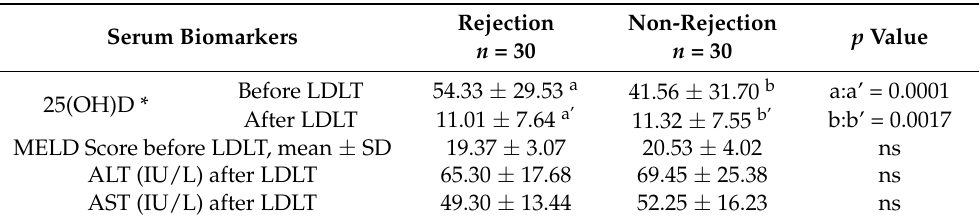
Table 4. Serum 25(OH)D concentrations in recipients before and after LDLT with rejection ( n = 30) and non-rejection ( n = 30) graft